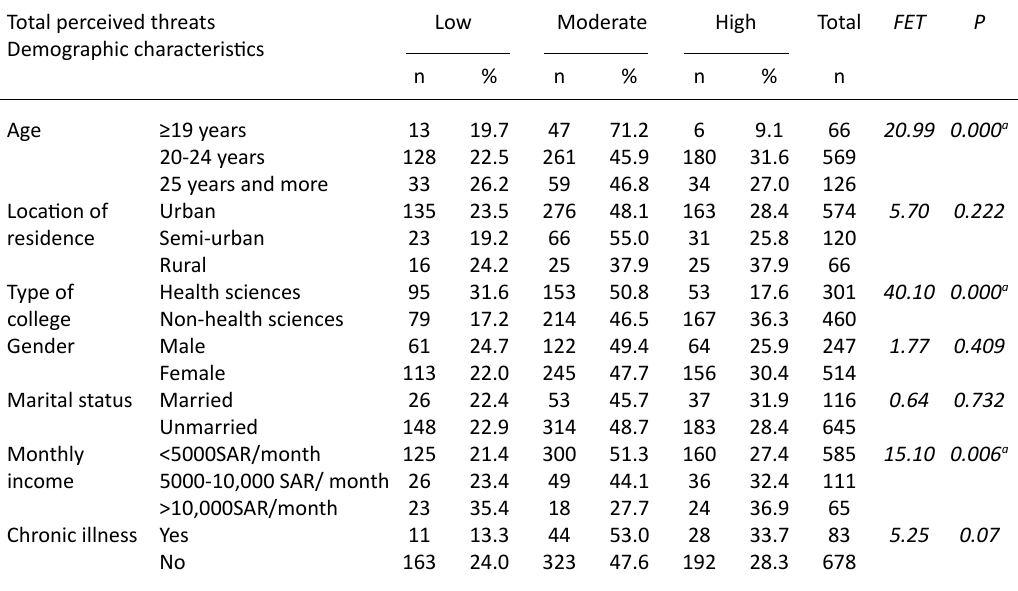
table 5. Relationship between total perceived threats and their demographic characteristics (n=761) Total perceived threats